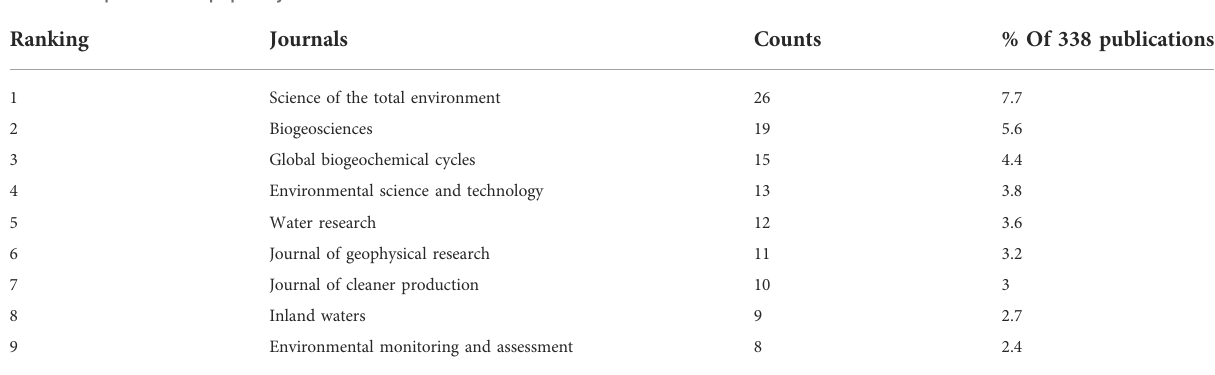
TABLE 3 Top nine most popular journals in GHG-HR research fi eld.